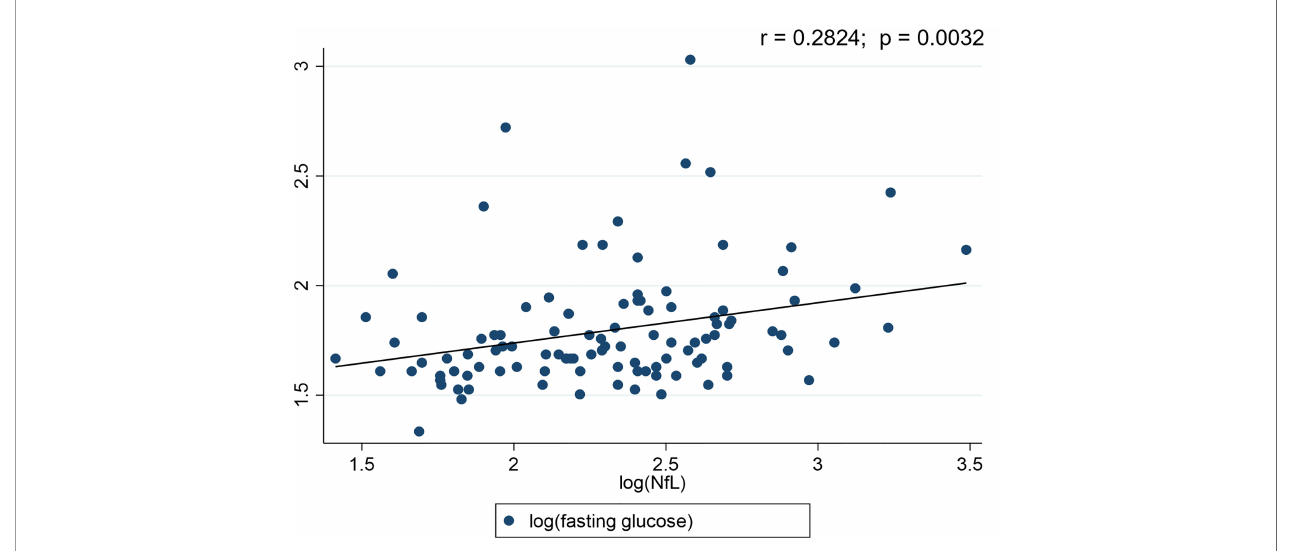
FIGURE 2 | Scatter plots for Neuro fi lament light chain (NfL) and diabetes status. r-value represents the correlation between the blood glucose levels and